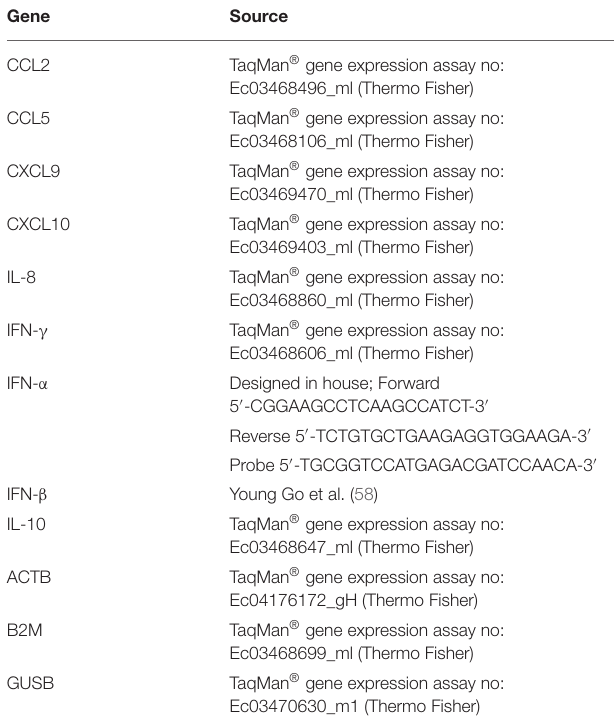
TABLE 2 | Primer and probe source